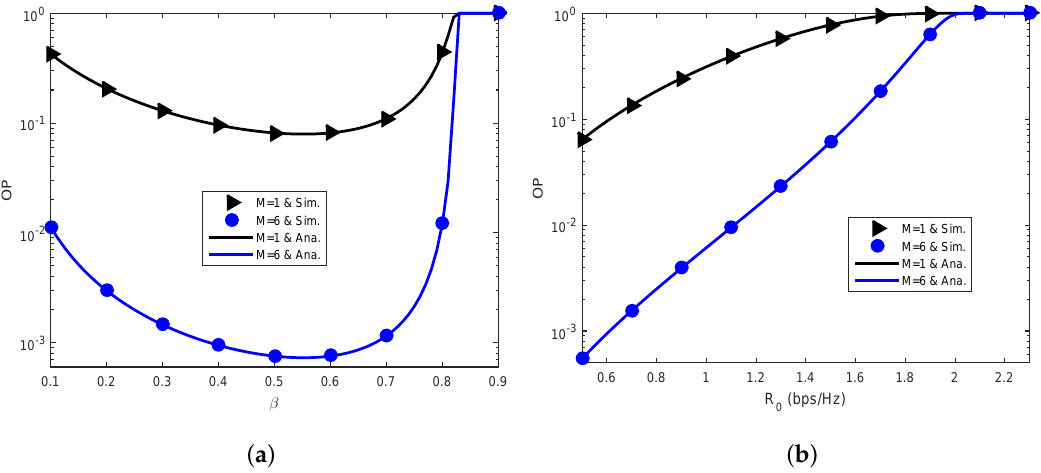
Figure 5. Effects of parameters ( β , R 0 ) . ( a ) OP versus β . ( b ) OP versus R 0